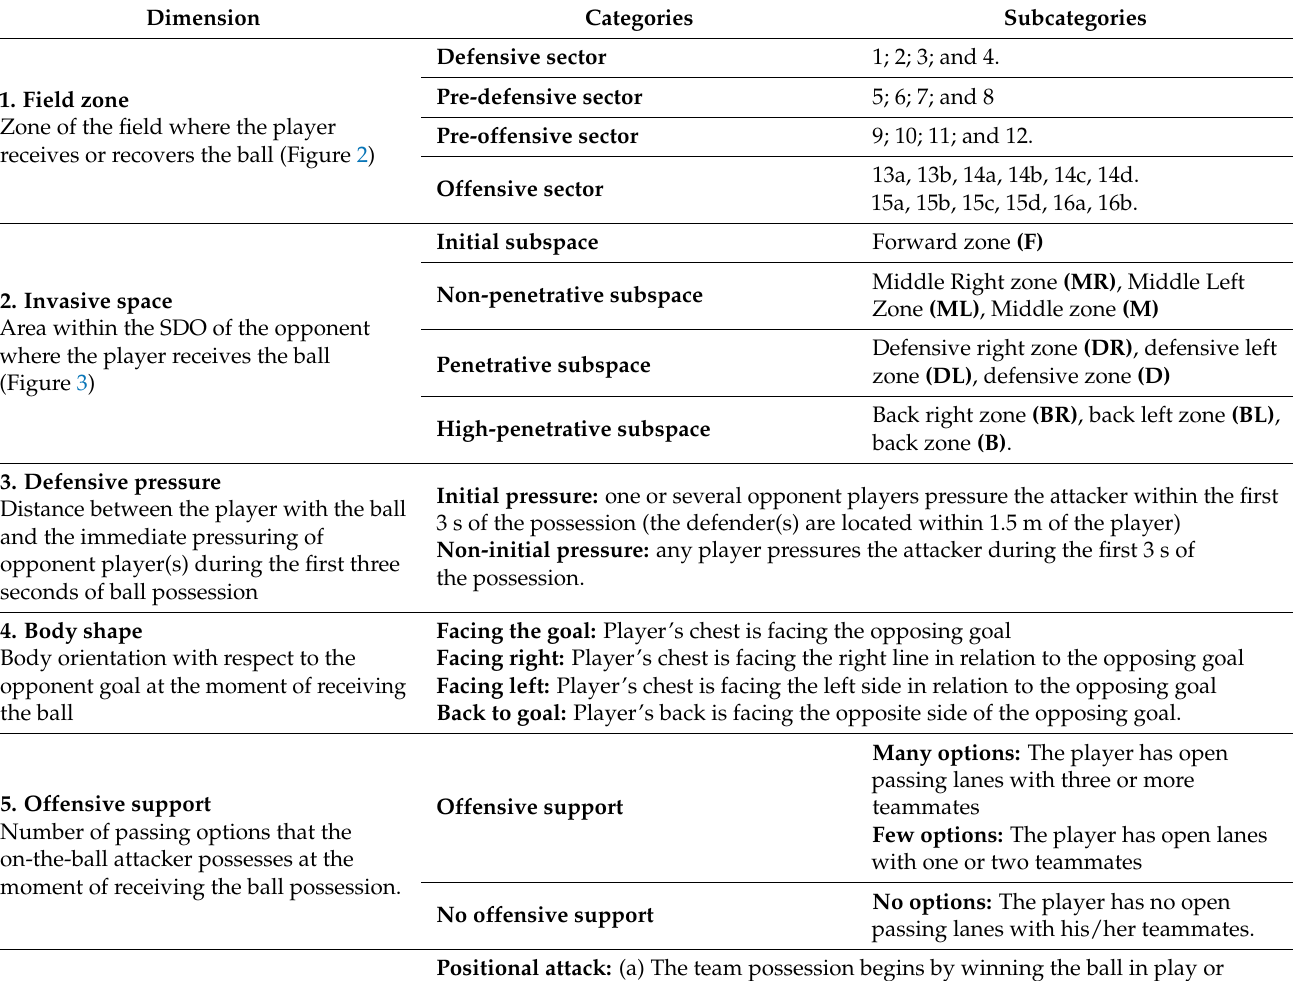
Table 1. Operational definitions for the dimensions included in the moment of receiving the